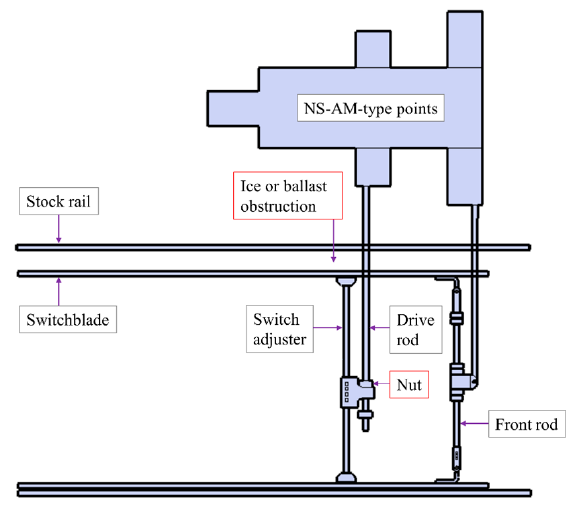
Figure 7. Schematic for NS-AM-type railway points [1].